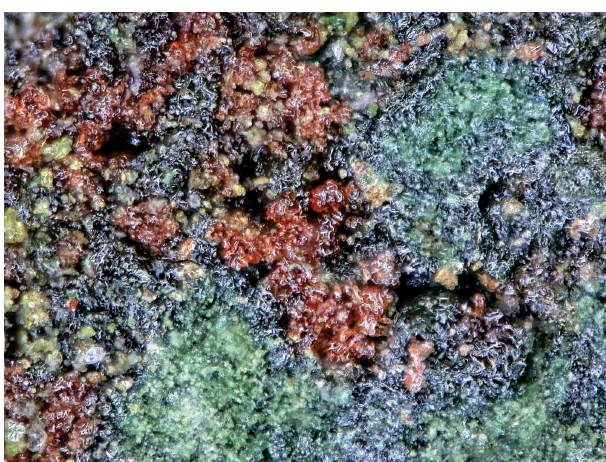
Figure 3. Niasite (red) with aerugite (green) and xanthiosite (yel- low) on cotype specimen (LACMNH 74203); FOV 0.56mm